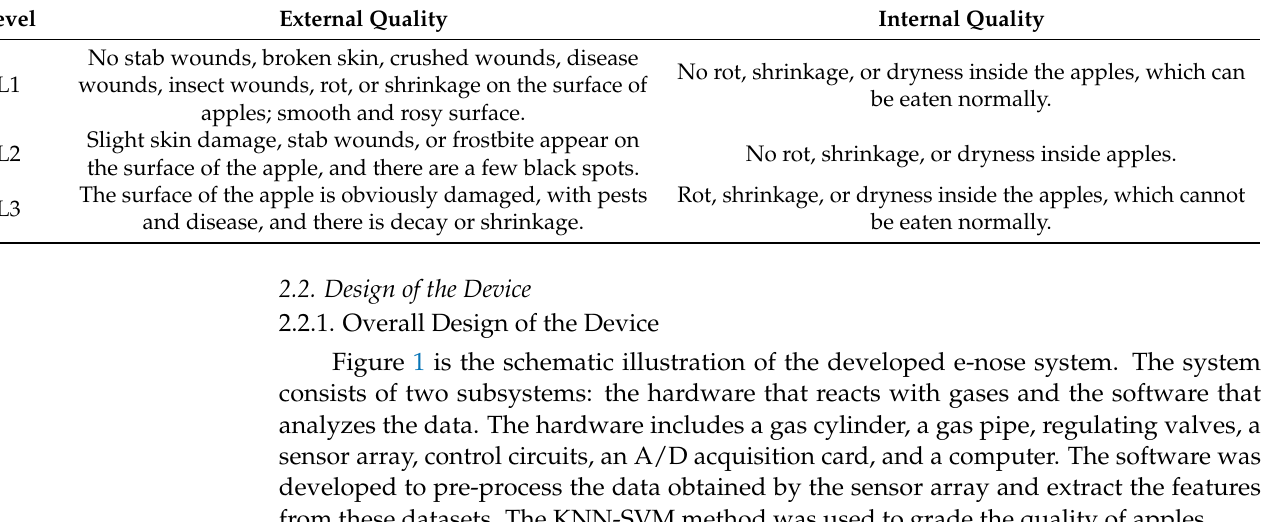
Table 1. Descriptions of the three levels of apple quality: L1, L2, and L3.